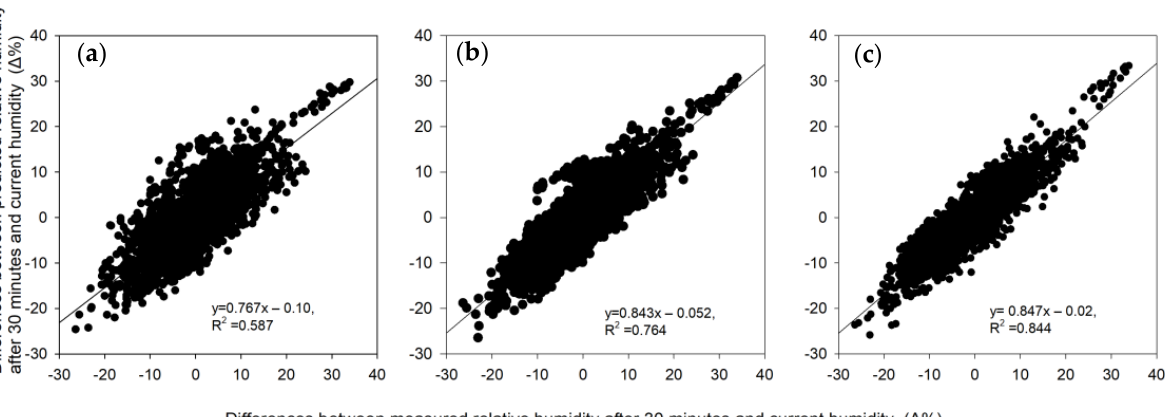
Figure 6. Comparison of changed relative humidity for predictive performance after 30 min (( a ) Model-1; ( b ) Model-2; ( c ) Model-3).